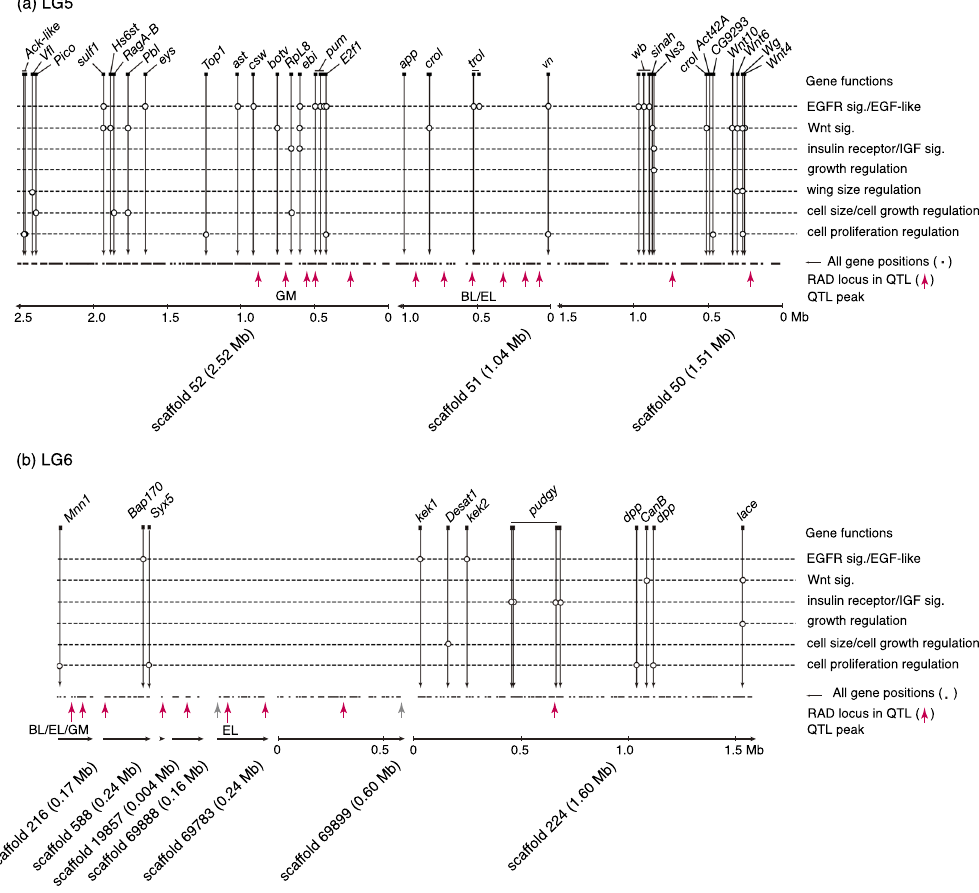
Figure 6. Genes potentially related to body size QTLs on scaffolds of two linkage groups, LG5 ( a ) and LG6 ( b ). Red upward asterisks indicate restriction site-associated DNA (RAD) loci with significant QTL LOD scores. Genes shown here are those related to the regulation of cell proliferation, cell size/cell growth, and wing size, and growth; and those involved in or regulating the insulin receptor/insulin-like growth factor signalling pathway, the Wnt signalling pathway, and the epidermal growth factor/epidermal growth factor receptor signalling pathway. Open circles indicate functions known for the gene located at the position. See Table S3 (Supplementary Information) for precise gene names and gene ontology